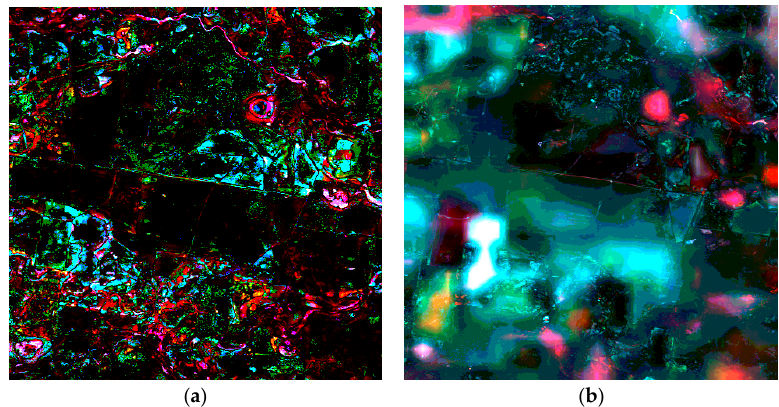
Figure 8. NIR-red-green composites of the squared error (with max values for bands NIR, red and green are 0.0023, 0.0002 and 0.0002) ( a ) and estimation variance (with max values for bands NIR, red and green are 0.0019, 0.0008 and 0.0005); ( b ) results for the second dataset. Table 4. The percentages of the squared error ( (cid:2026) (cid:3017)(cid:2870) ) that is lower than the estimation variance ( (cid:2026) (cid:3006)(cid:2870) ) for the second dataset.